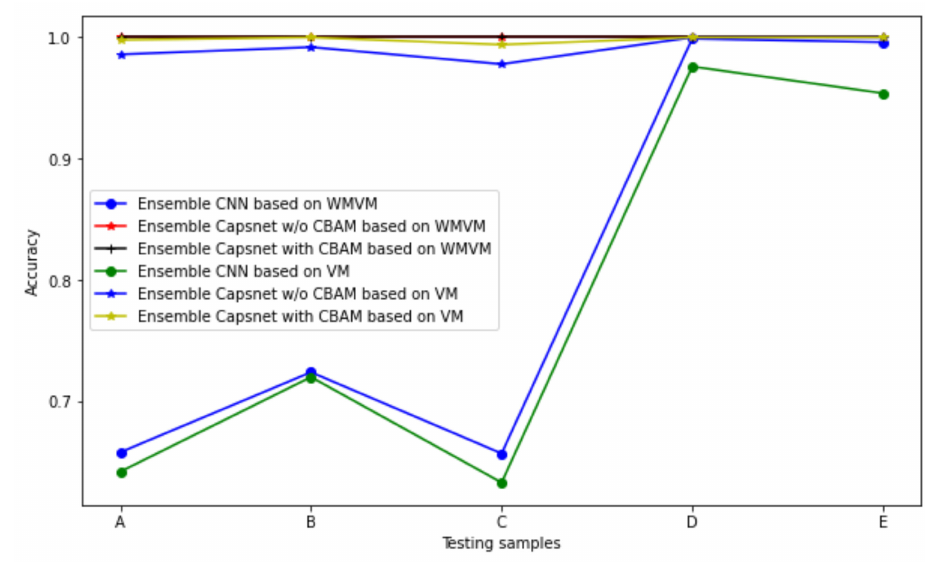
Figure 12. Diagnostic accuracy for different datasets based on different fusing methods.